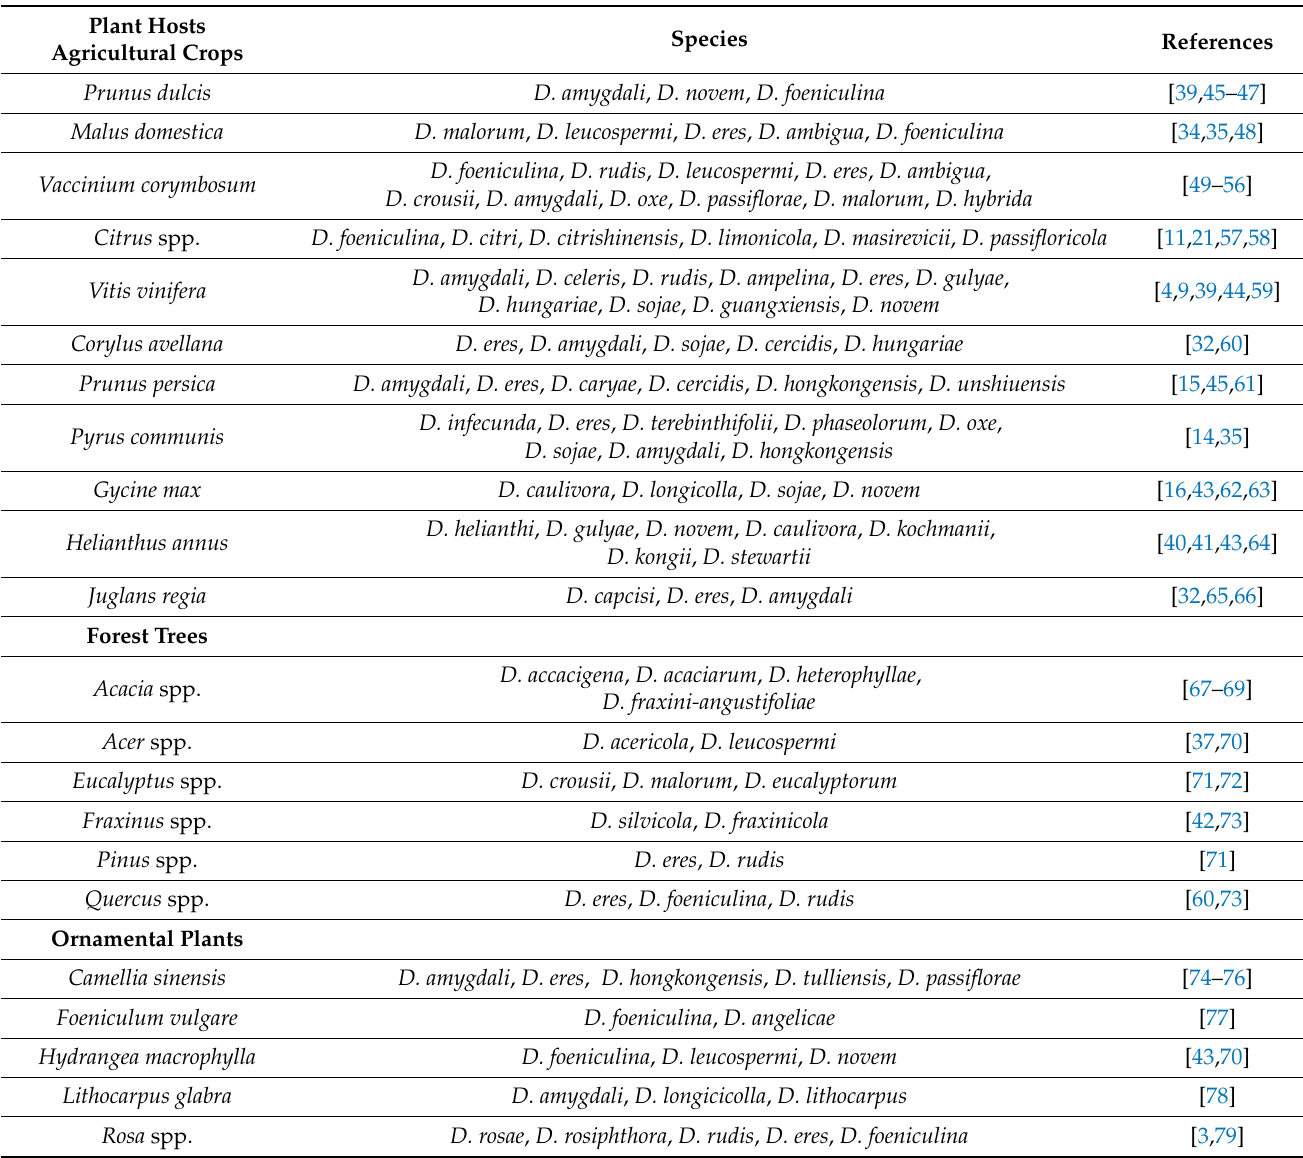
Table 1. Synopsis of some plant hosts reported for Diaporthe